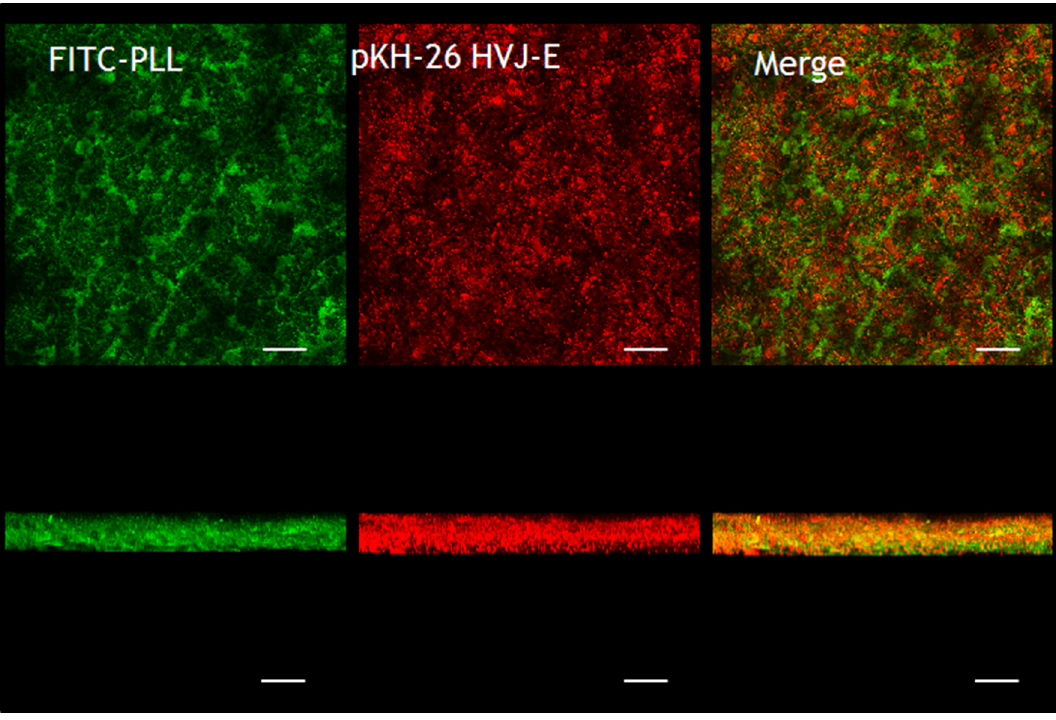
Figure 4. Fluorescent images of HVJ ‐ E immobilized nanofibers observed by CLM. PLL and HVJ ‐ E were stained with FITC (green) and pKH ‐ 26 (red), respectively. Top ‐ view (top) and cross ‐ sectional (bottom) images of the nanofiber mesh (scale bars = 50 μ m).